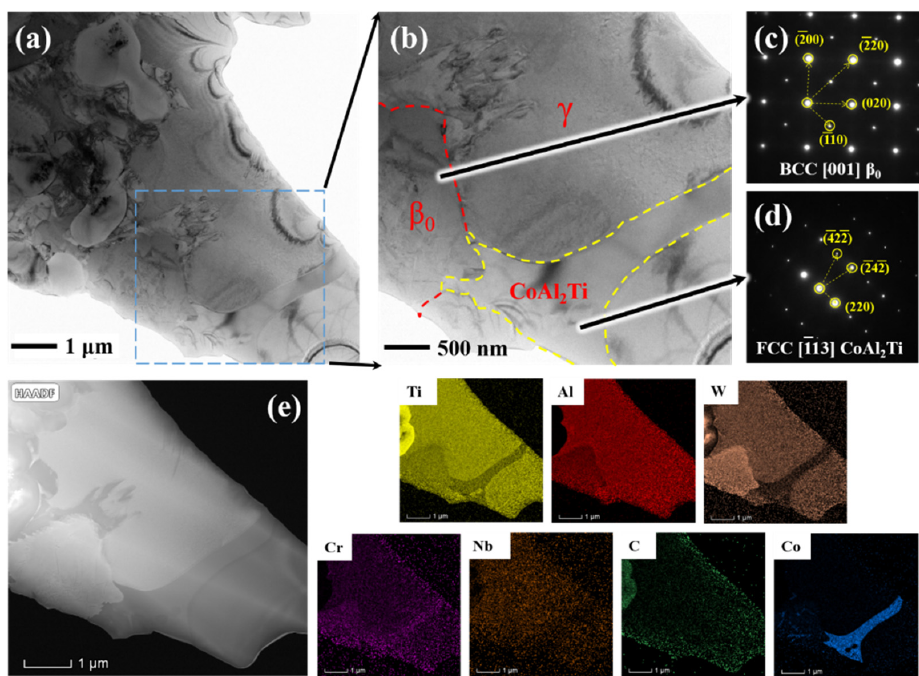
Figure 5. TEM characterization of the 10 WC composite coating. ( a ) Bright ‐ field TEM image. ( b ) The Bright ‐ field TEM of partial enlargement ( a , c , d ) SAED pattern of the β 0 phase and CoAl2Ti phase. ( e ) TEM ‐ HAADF image of the TEM ‐ EDS mappings of ( a ).